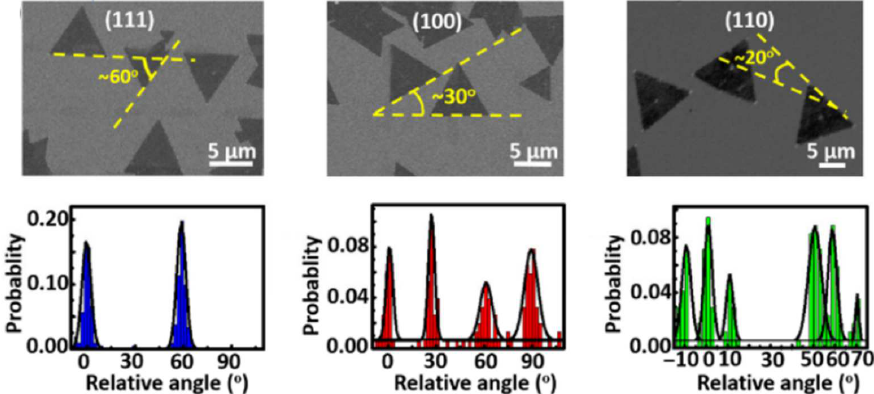
Figure 16. Representative SEM images of h-BN grown on Cu (111), Cu (100), and Cu (110). Statistical distributions of the edge angles of individual triangular h-BN domains grown on Cu (111), Cu (100), and Cu (110) faces [75].